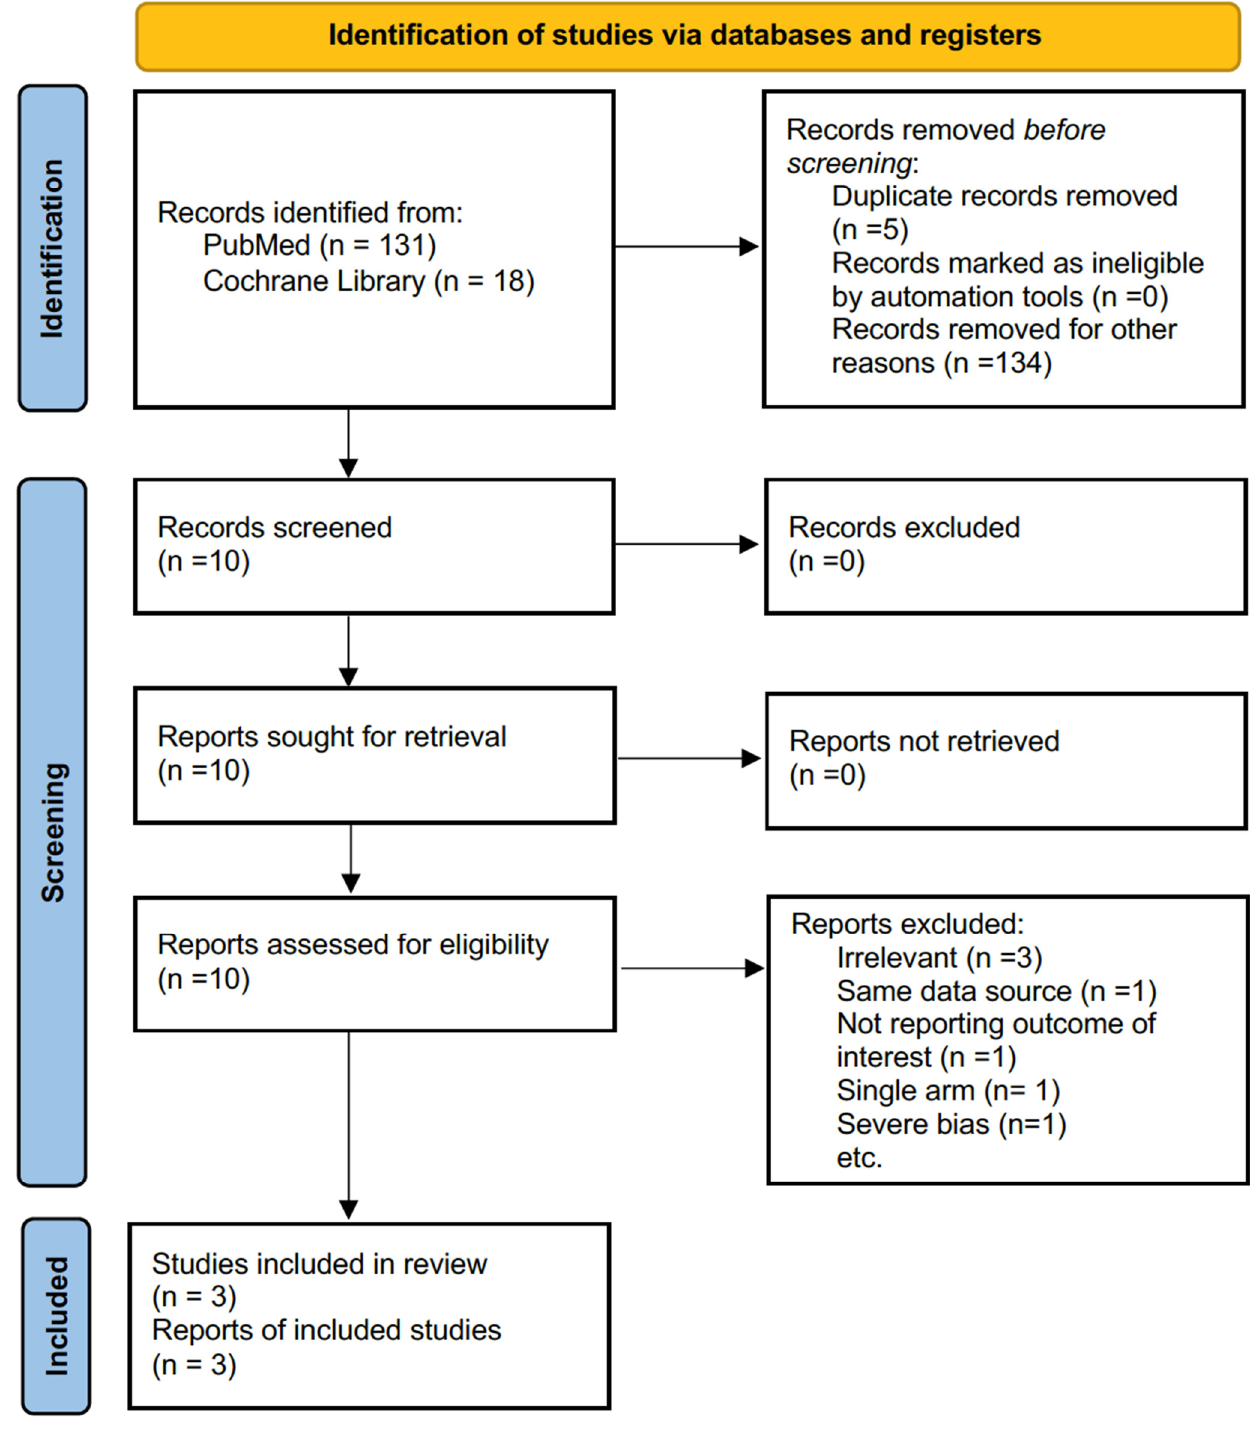
Figure 1. Preferred reporting items for systematic reviews and meta-analyses diagram for article selection.